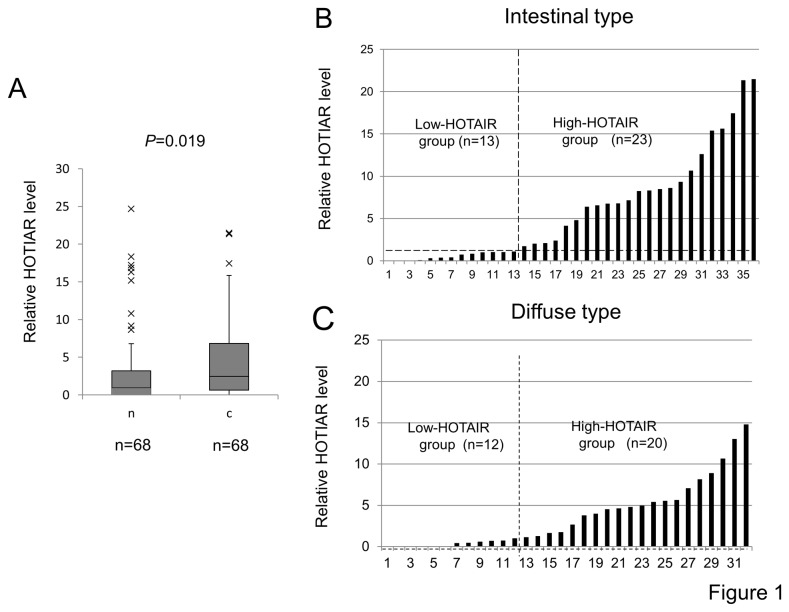
The expression of HOTAIR in human gastric carcinoma tissues.
A, HOTAIR expression levels of cancerous and adjacent noncancerous tissues from the gastric cancer patients were examined by qRT-PCR and normalized by the GAPDH expression level. The expression levels of HOTAIR were significantly higher in carcinoma lesions compared to those of non-cancerous lesions (P= 0.019). B and C, The human gastric cancer tissues were further classified according to the HOTAIR expression level into a High-HOTAIR group (HOTAIR / GAPDH >1.0) and Low-HOTAIR group (HOTAIR /GAPDH < 1.0) in the intestinal (B) and diffuse type (C) of gastric cancer, respectively.